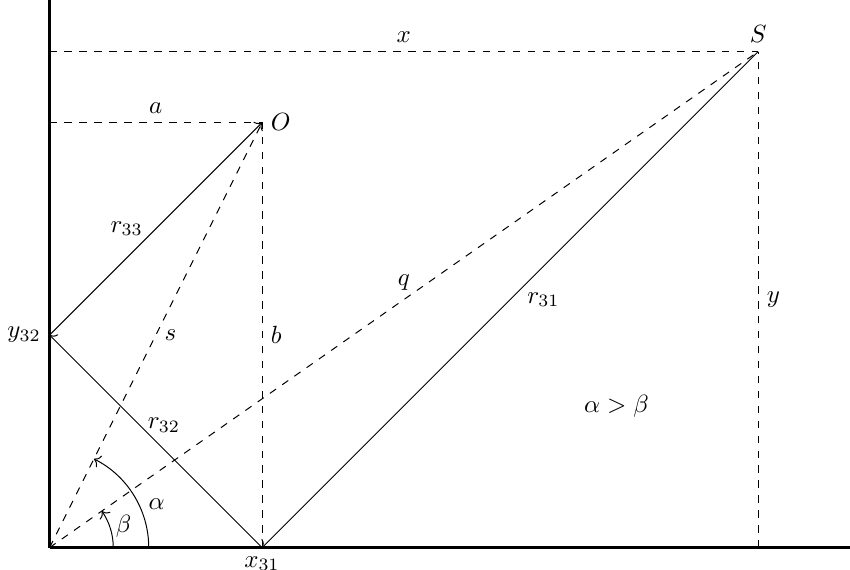
Figure 2: Sound source S and observer O near a corner, with elevation angle for the latter α larger than for the former β , that is, β < α , showing only the reception path with two intermediate